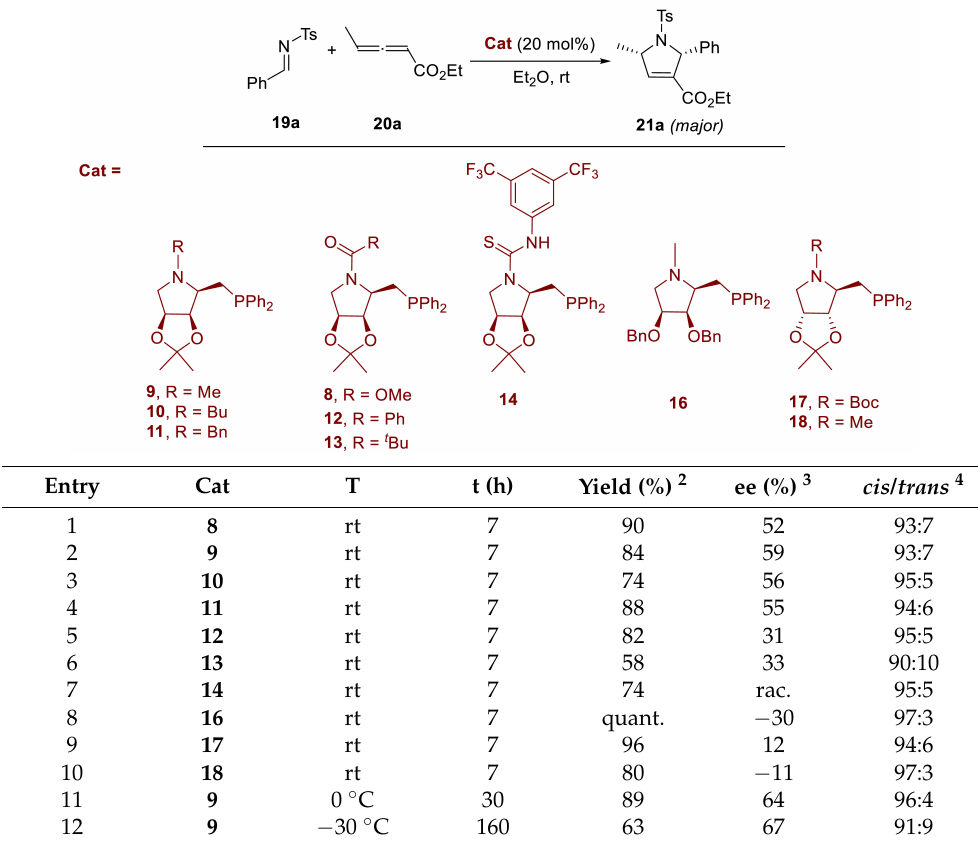
Table 3. Screening of organocatalysts 1